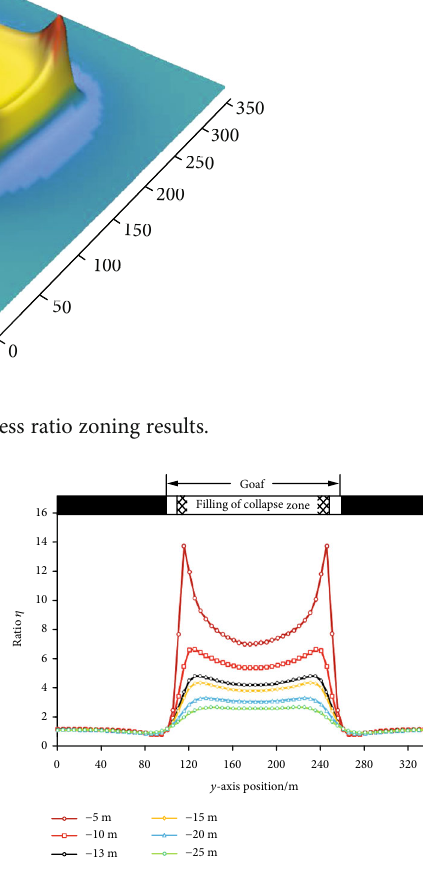
Figure 12: The ratio of two-way stress at di ff erent depths at the position of monitoring line